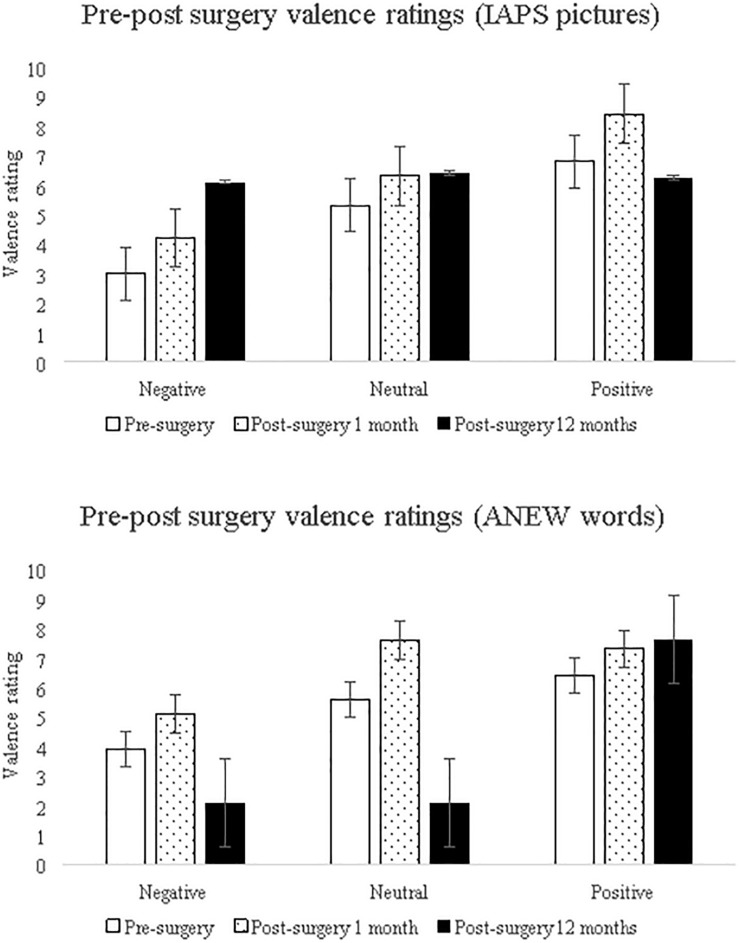
The patient’s valence-specific pre- and post-surgical affect ratings using affect-eliciting pictures (IAPS: top) and words (ANEW: bottom). Error bars show the standard error.